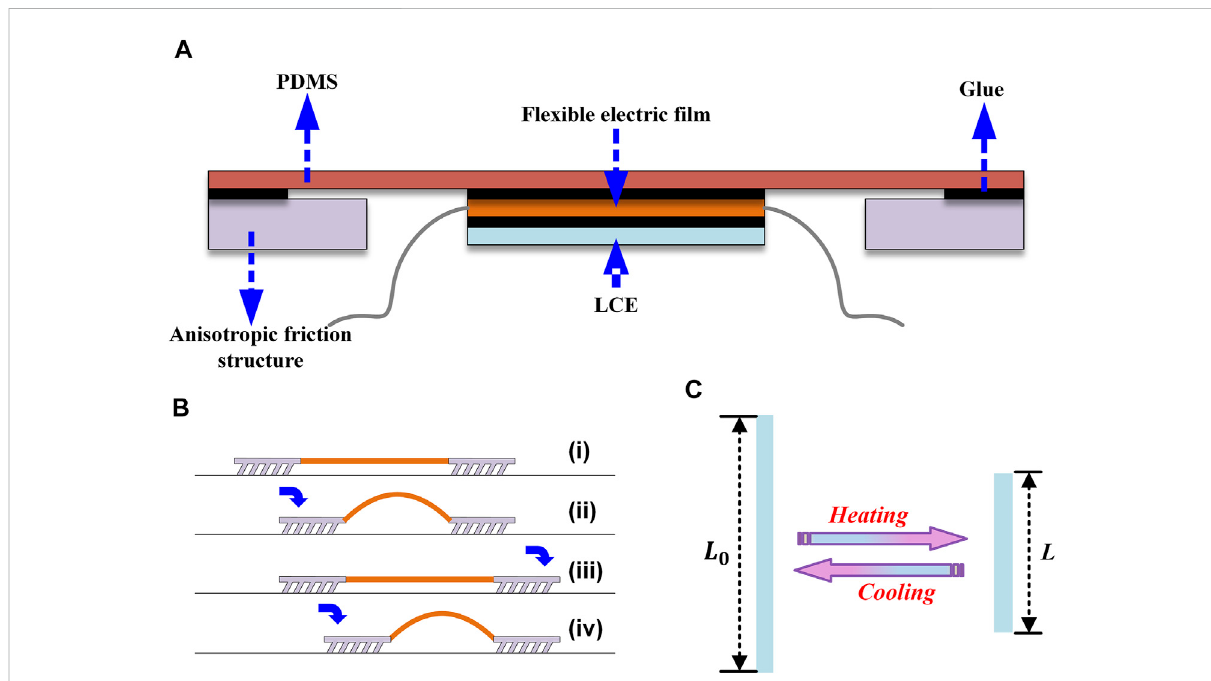
FIGURE 1 Schematic diagram of the structural design of the inchworm-inspired soft robot: (A) A schematic depiction of the robot ’ s overall construction. The actuating part is composed of LCE and fl exible electrothermal fi lm. The black part in the fi gure represents the glue bonding part. (B) Creep mechanism of an anisotropic friction structure. The robot can move forward when the actuation component is arched and stretched. (C) Thermal actuation principle of the LCE. When the temperature approaches the nematic-isotropic transition temperature, the elastomer will show a macroscopic change in length. When the temperature approaches the nematic-isotropic transition temperature, the length of the LCE rapidly shortens. The changing process is exactly the opposite when cooling from a high